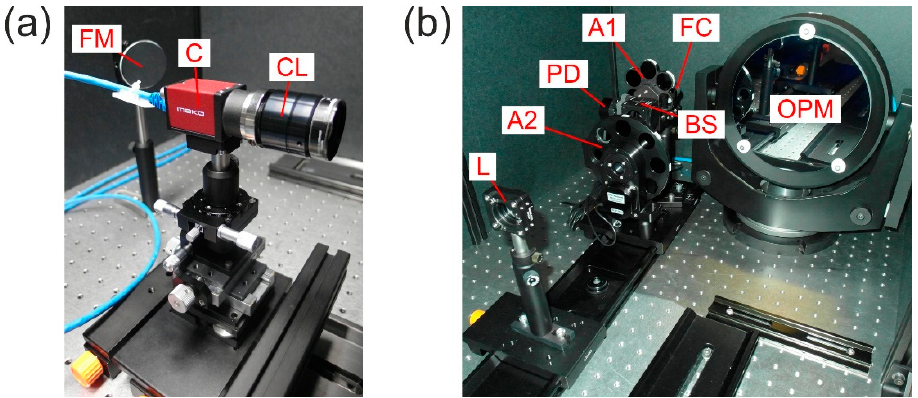
Figure 5. Photographs of different parts of the experimental setup: ( a ) camera C with camera lens CL and folding mirror FM and ( b ) fiber collimator FC, attenuators A1 and A2, beam splitter BS, (reference) photodiode PD, focusing lens L and off-axis parabolic mirror OPM.